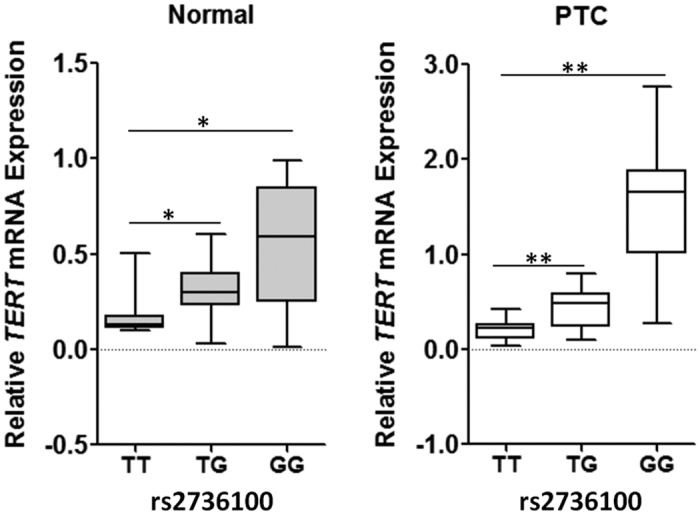
TERT mRNA expression in normal and cancerous thyroid tissues grouped by rs2736100 genotypes.The expression of individual TERT mRNA was calculated relative to expression of β-actin using the 2−dCt method. **P < 0.01.